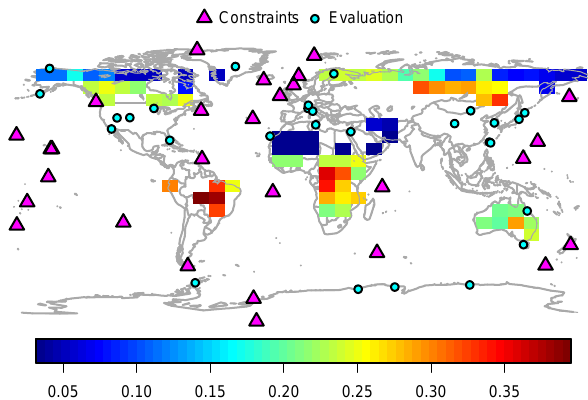
Figure 1. Location of the CO 2 observations (for constraining the model and for evaluation) and the temporal median of the TIP- FAPAR uncertainties (given with the colour scale) in each pixel act- ing as a